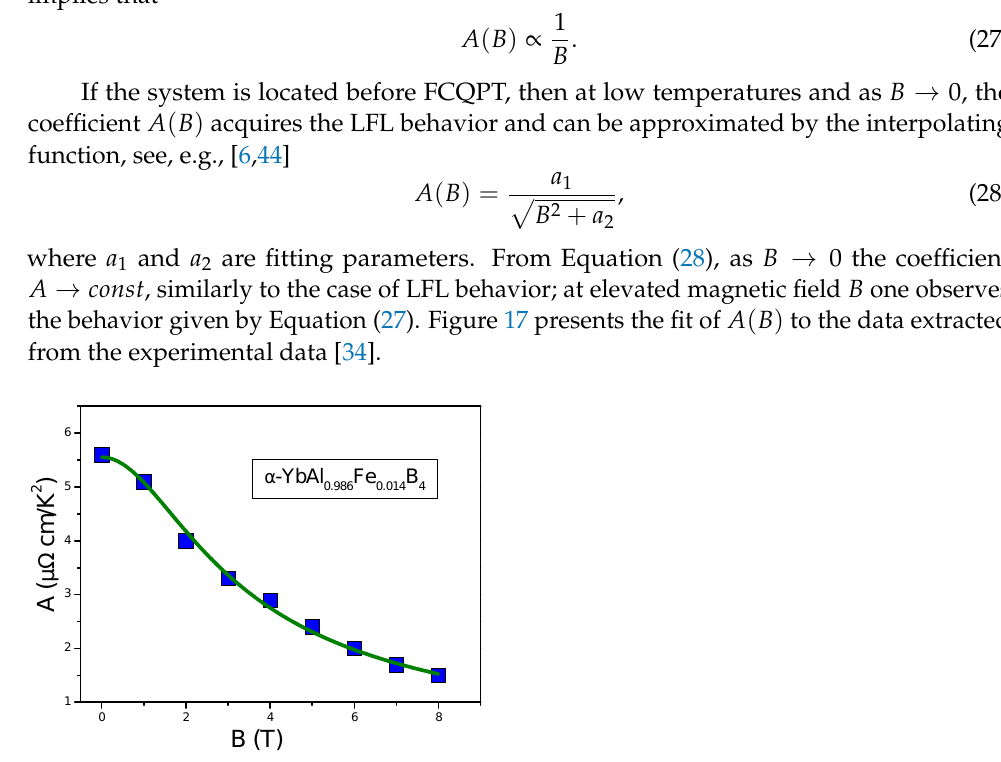
Figure 17. Experimental data for the coefficient A ( B ) , plotted as a function of magnetic field B (solid squares). Measured values of A ( B ) are extracted from the experimental data [34]. The solid curve is given by Equation (28).